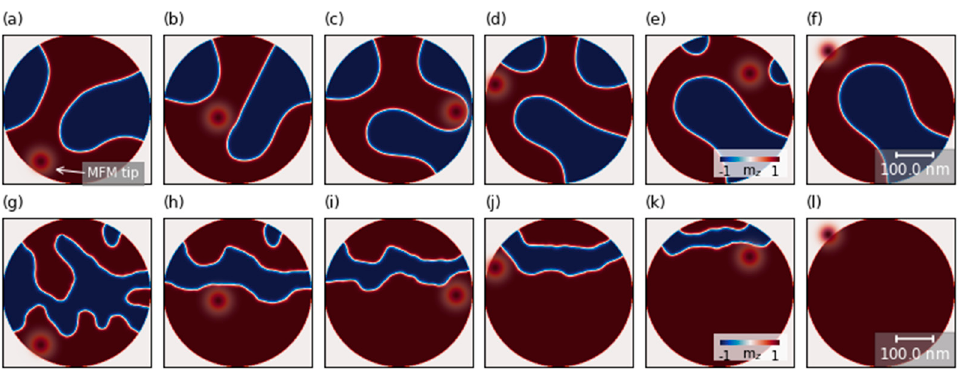
Figure 4. Simulated images of the z-component of the magnetic configuration evolution without pinning centers ( a – f ) and with the pinning centers ( g – l ) in nanodots dependent on position of the local magnetic field. The red circle represents the z-component of the magnetic field induced by the high-momentum tip. Simulations were performed for 400 nm disks with 7 repetitions of the stack with DMI = 1.0 mJ/m 2 . The amplitude of the local magnetic field was 350 mT at the center of the spot, and spot diameter was equal to 50 nm. The colors represent the orientation of the z-component magnetization.